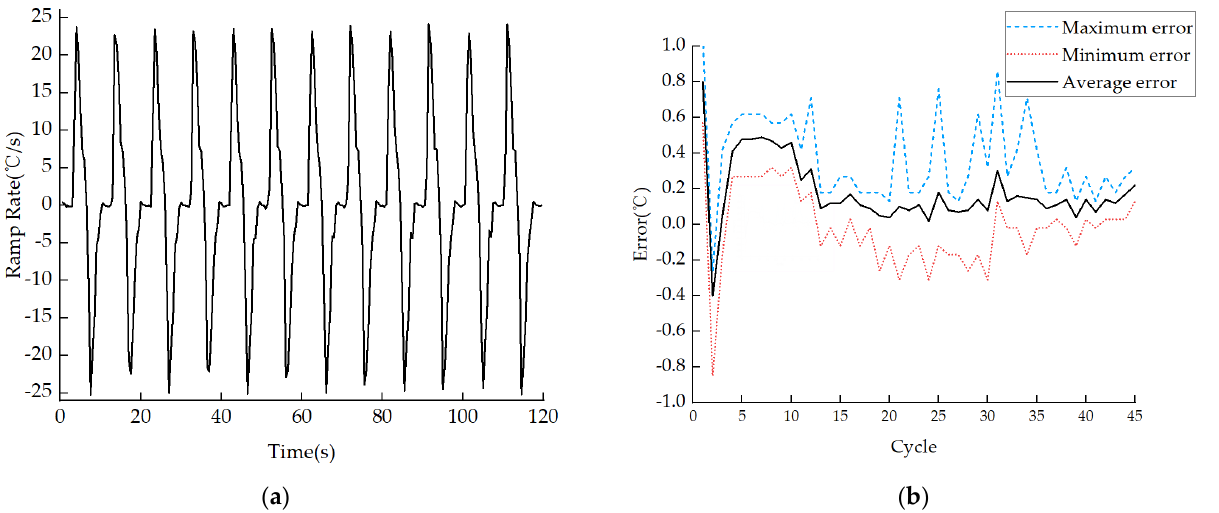
Figure 12. Ultrafast PCR thermocycler thermal cycling performance: ( a ) Heating and cooling ramp rates of solution; ( b ) Error between actual temperature and target temperature of solution in anneal- ing stage.